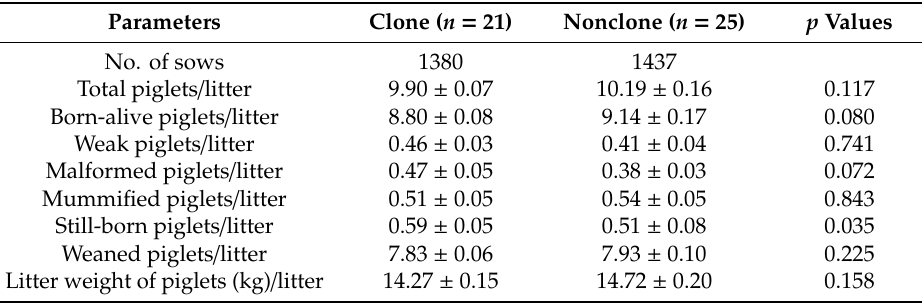
Table 3. Reproductive performance of cloned and non-cloned Pietrain